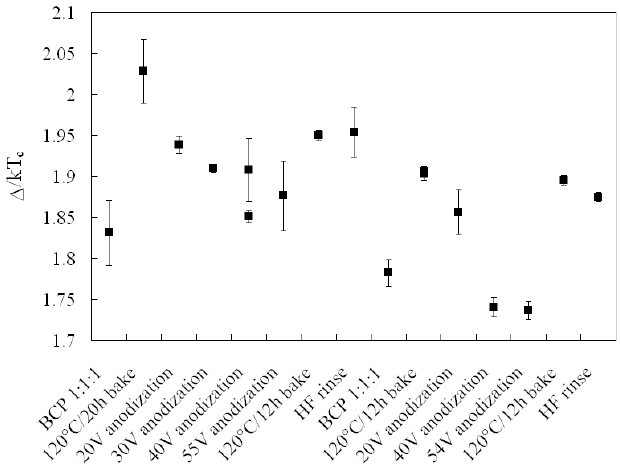
FIG. 6. (Color) Q vs B measured at 1.7 K for several baking p 0 conditions. Baking at 180 (cid:3) C in air caused a significant degra- and of the quench field which were not recovered dation of Q 0 by multiple HF rinses and by in situ baking at 120 (cid:3) C